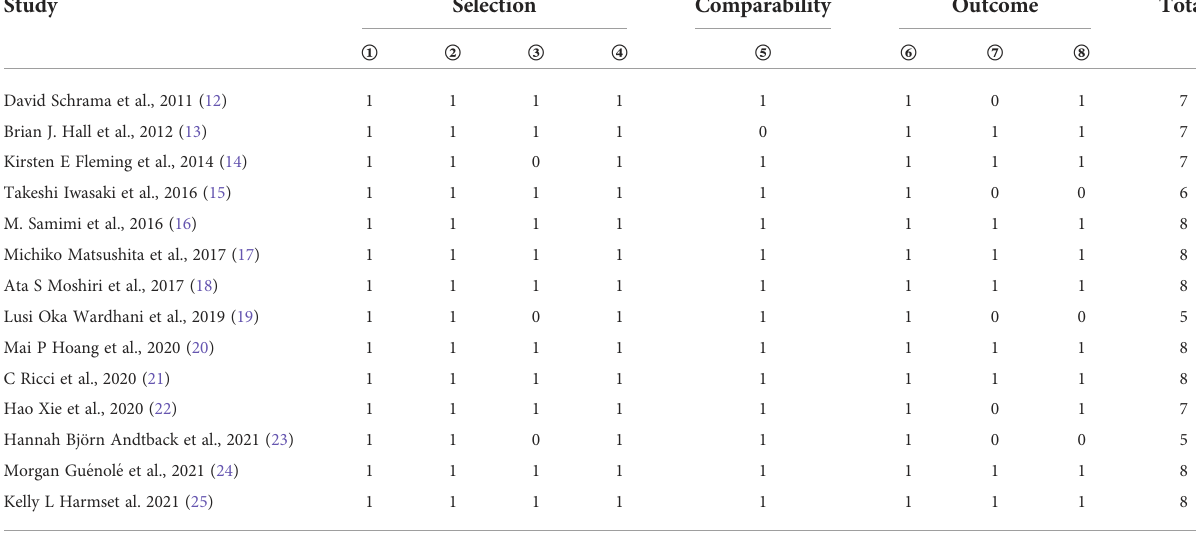
TABLE 3 Quality assessment via Newcastle Ottawa scale and recall bias risk.